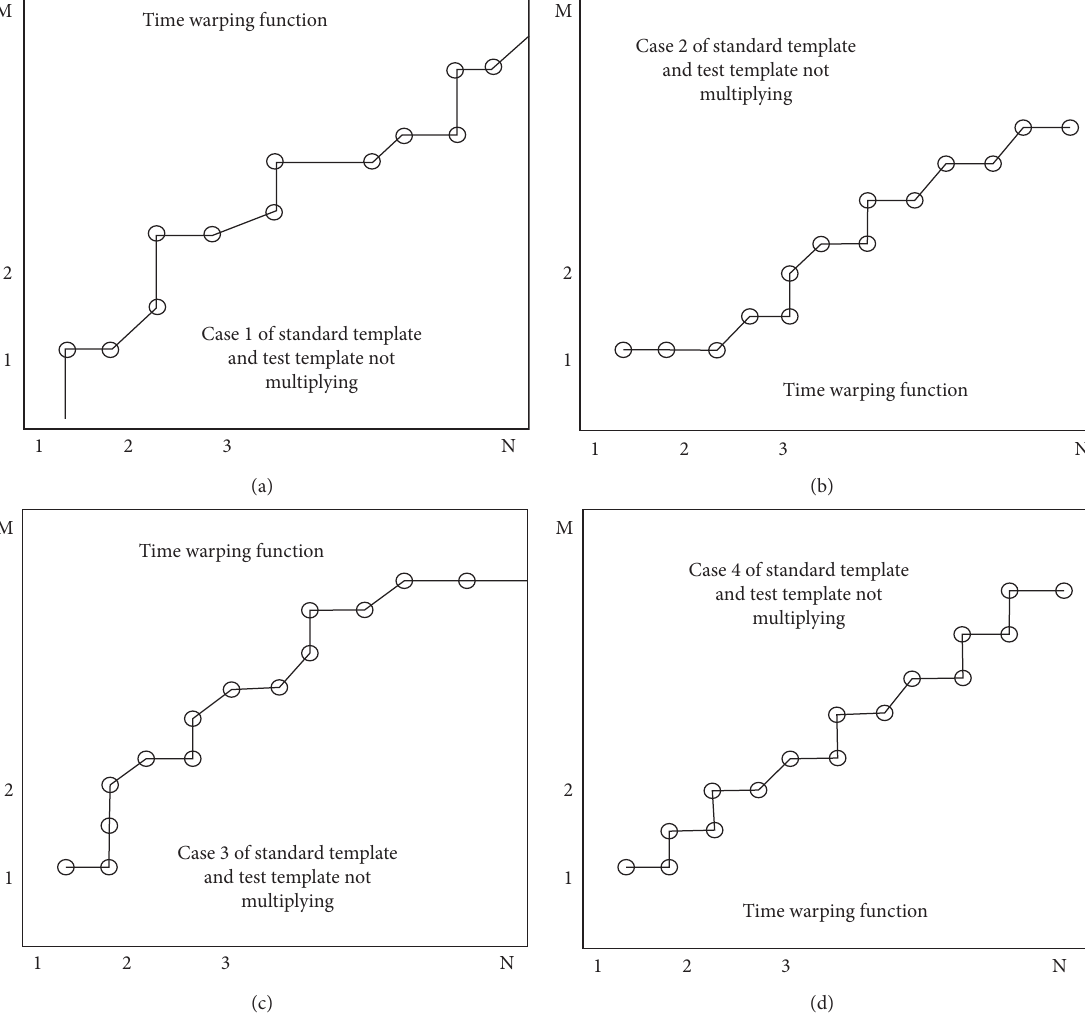
Figure 4: Schematic diagram of the dynamic time adjustment